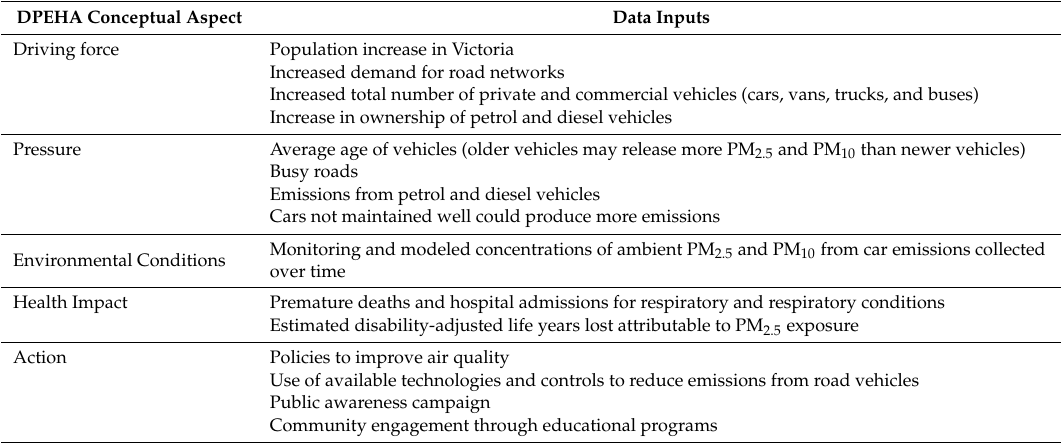
Table 3. Application of the DPEHA conceptual framework to anthropogenic PM 2.5